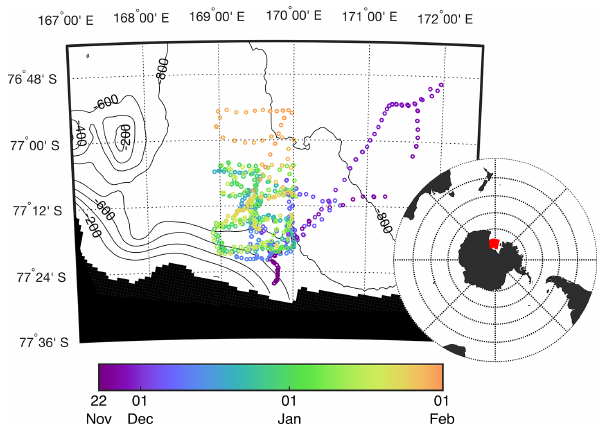
Figure 1. Southern Ross Sea showing transect locations where the glider was at the surface. The color of each glider dive indicates the date. Bathymetric contours are shown at 200m intervals, as ob- tained from the bedmap2 bathymetric data (Fretwell et al.,